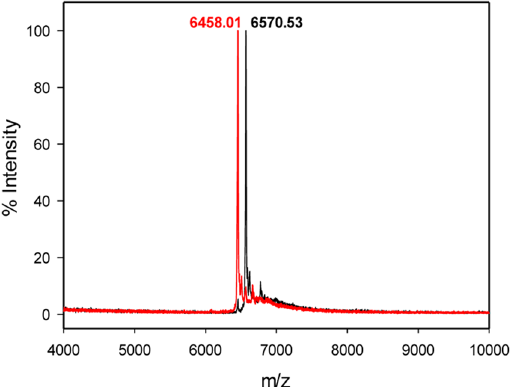
Figure 4. MALDI-TOF MS analyses. Data showing the isotopic average molecular mass (m/z) of the two recombinant protein variants AfpB * (red) and AfpB (black) produced in P . digitatum . The difference in the molecular mass fits with the extra leucine residue present at the N-terminus of the native protein